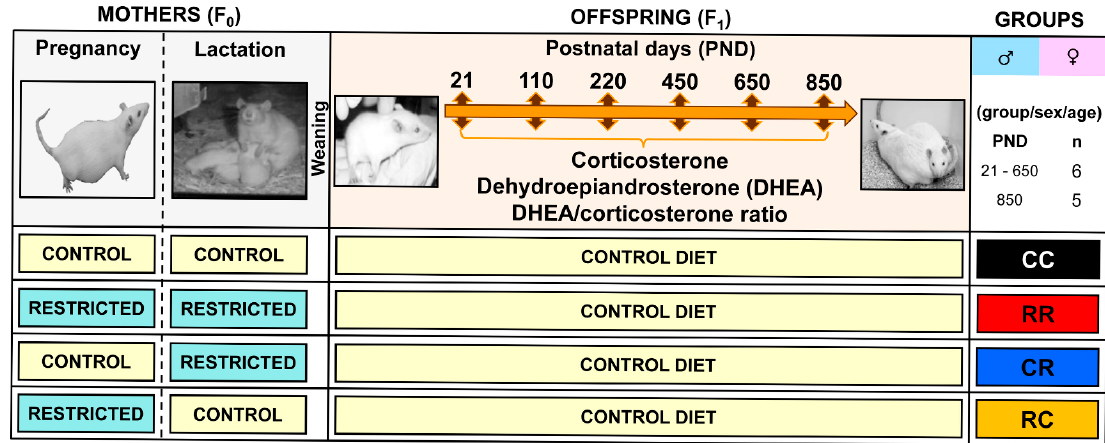
Figure 1. Timeline. Maternal protein restriction design. Female (F0) rats were fed with control (20% protein, C) or protein restricted (10% protein, R) diet during pregnancy and/or lactation, producing four offspring groups; first letter pregnancy, second lactation diet—CC, RR, CR, and RC. After weaning, both male and female offspring were fed with the control diet until postnatal day (PND) 850. Serum samples were taken at PND 21, 110, 220, 450, 650 and 850. n = 6 per group/sex/age with the exception of PND 850, in which n =